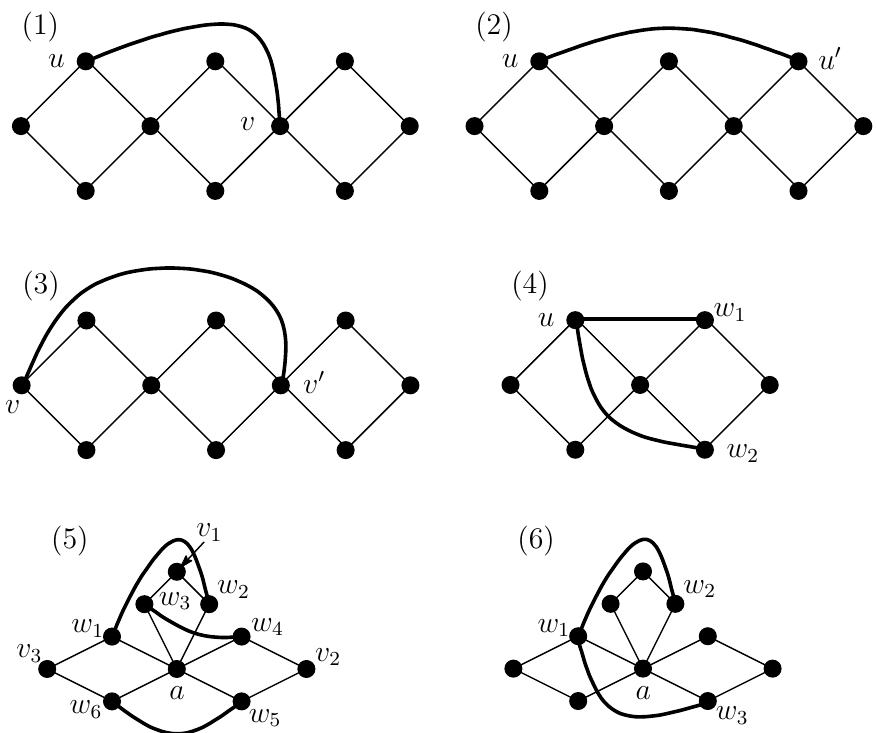
Figure 3: Six forbidden conditions in Proposition